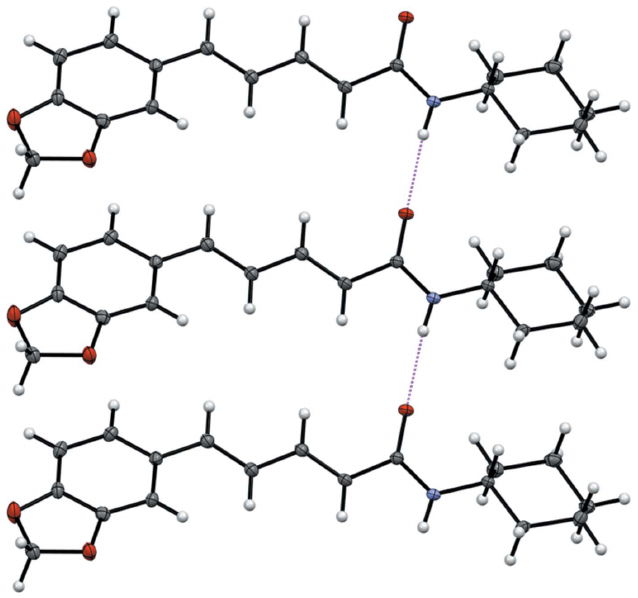
Figure 4 A view along the c- axis direction of the crystal packing of (I). The N— H (cid:2)(cid:2)(cid:2) O hydrogen bonds are drawn as dashed lines.